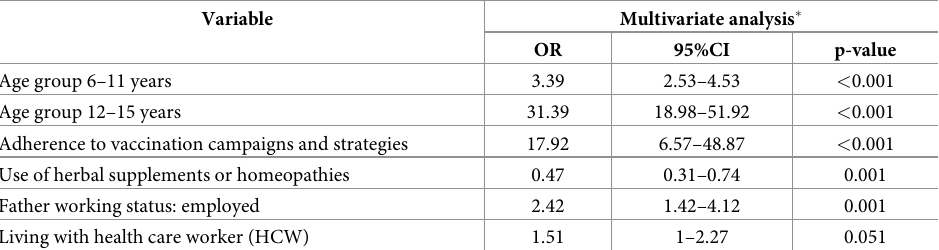
Table 5. Multivariate analysis between sociodemographic, perceptions, attitudes, behavior and knowledge indica- tors among parents of under 16 years students, in SSNC. Catalonia, January 2022.